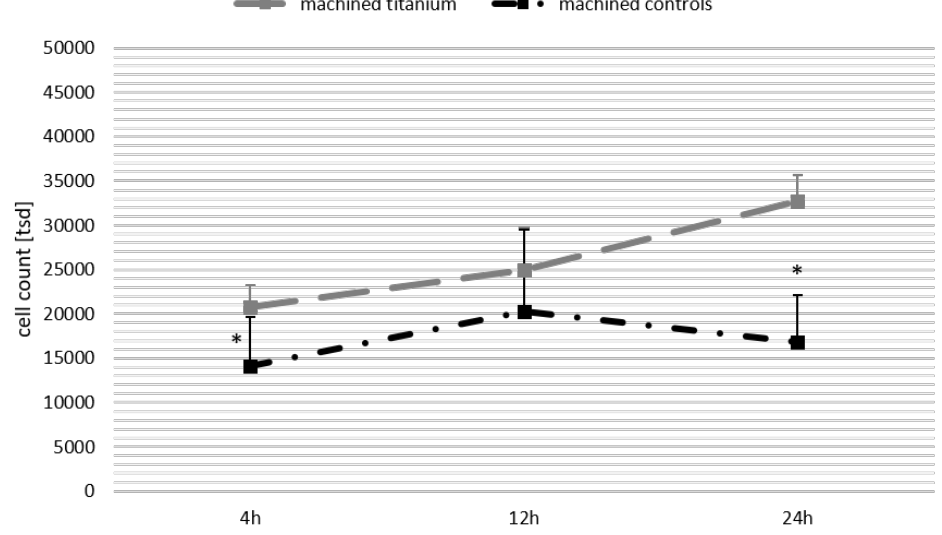
Figure 5. Comparison of cell count after 4, 12 and 24 h between machined titanium samples and controls. The squares correspond to the mean value, and the line on top corresponds to the ± standard deviation. Statistically significant differences ( p < 0.05) are marked with an asterisk.